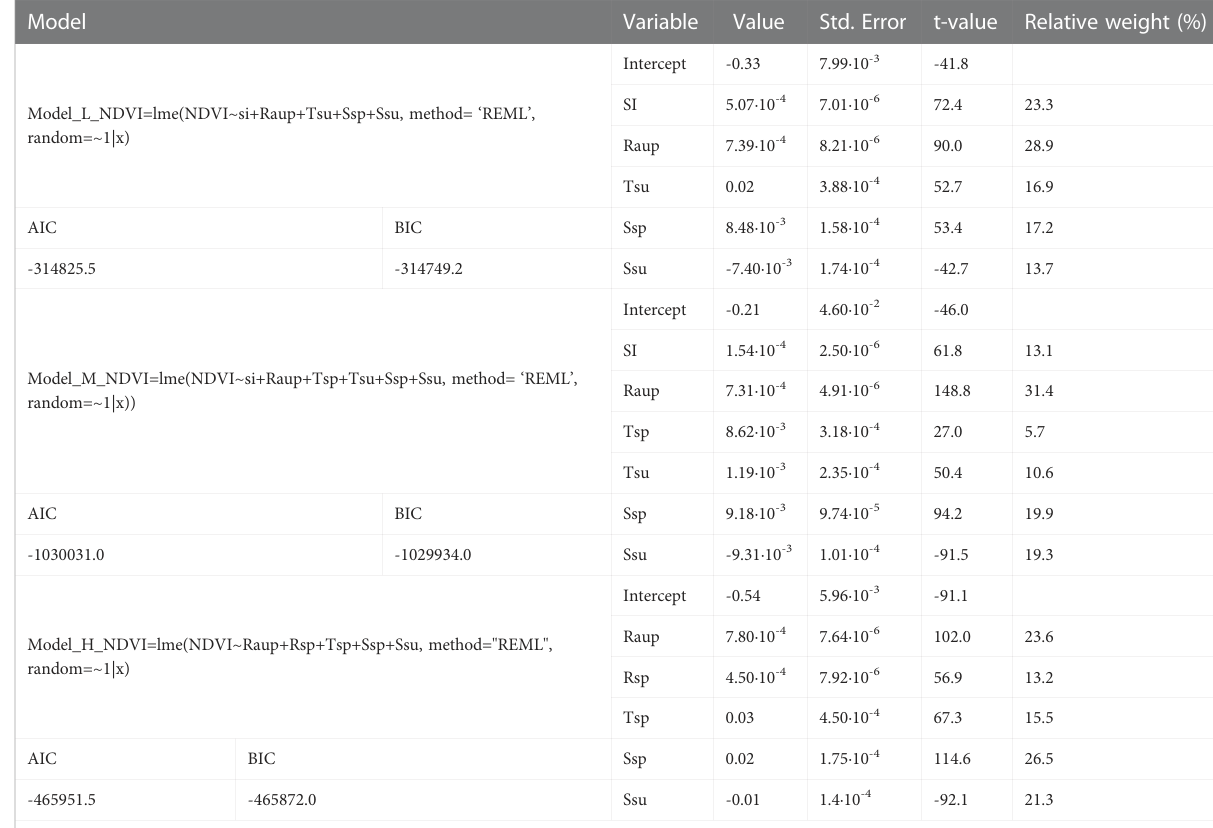
TABLE 2 Outputs of the best-supported models showed in Tables 1 . Model Variable